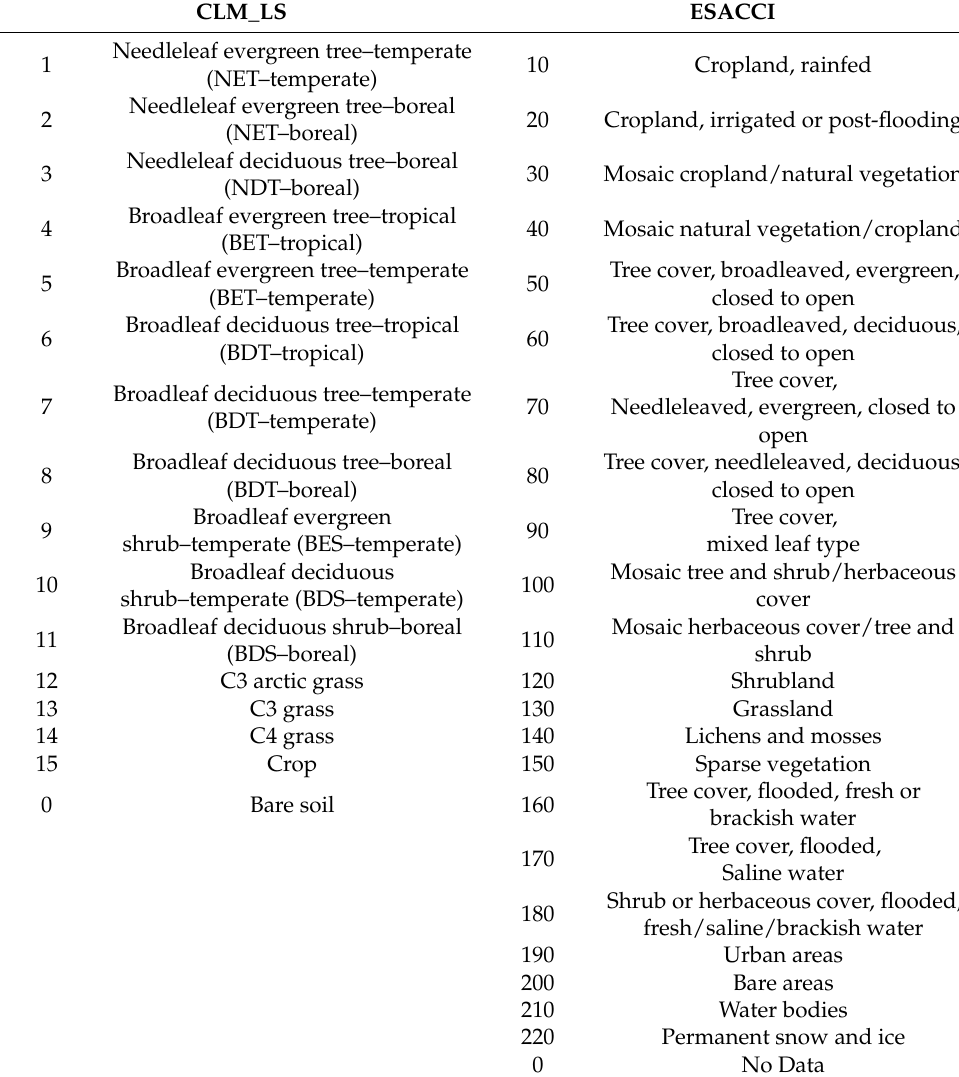
Table 1. Comparison of classification for CLM_LS and ESACCI.